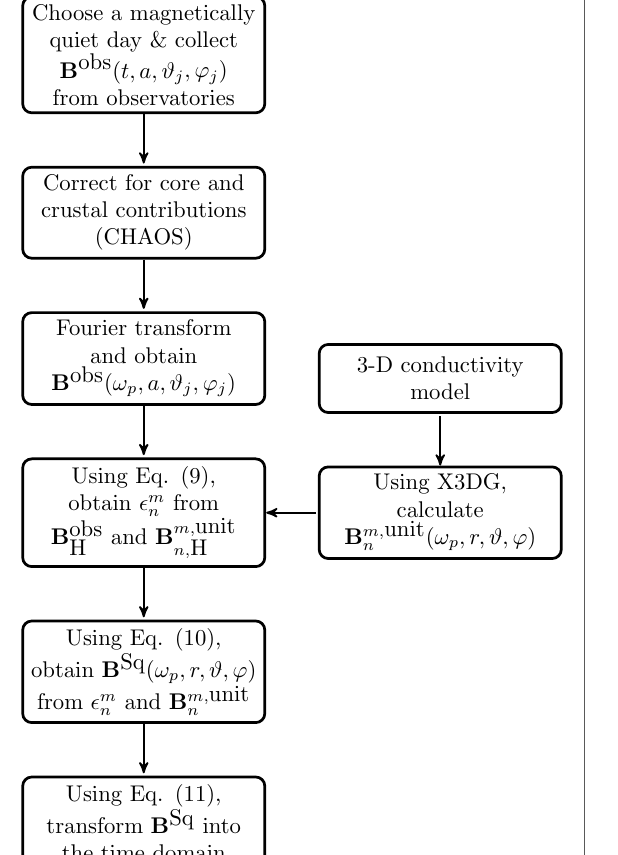
Table 2 Tidal constituents used in this study